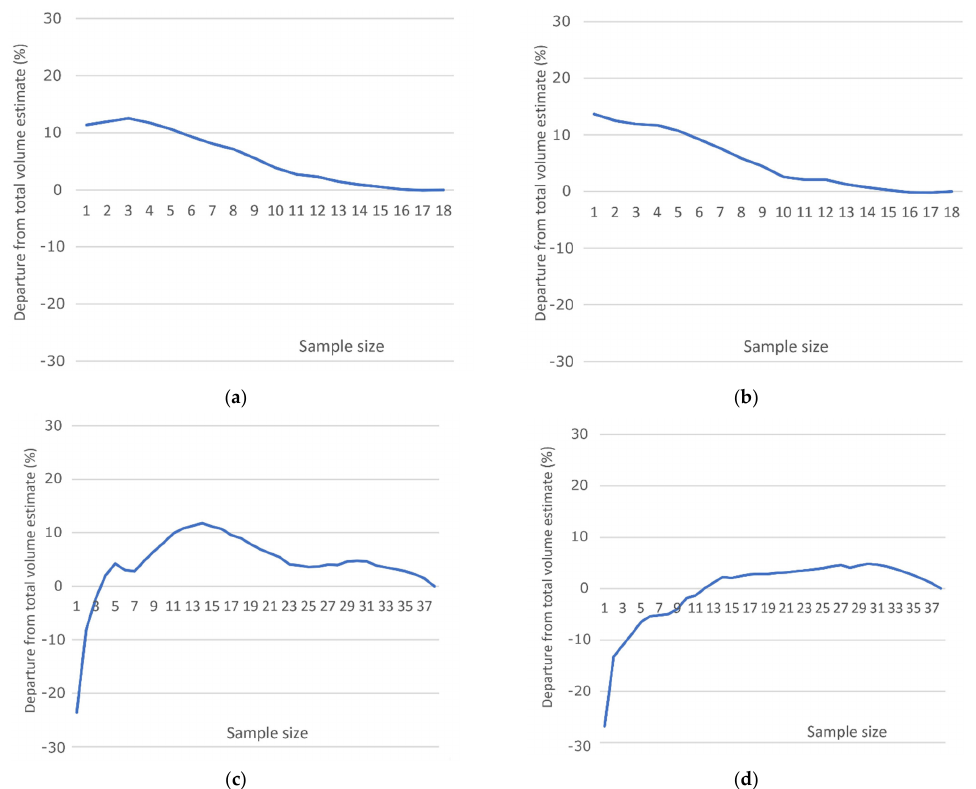
Figure 6. Statistical stability (per cent departure from whole-sample TRV estimate) of canopy volume field measurements as a function of sample size by survey date ( a ) 7 July 2016; ( b ) 2 August 2016; ( c ) 31 July 2017; ( d ) 26 June 2019.